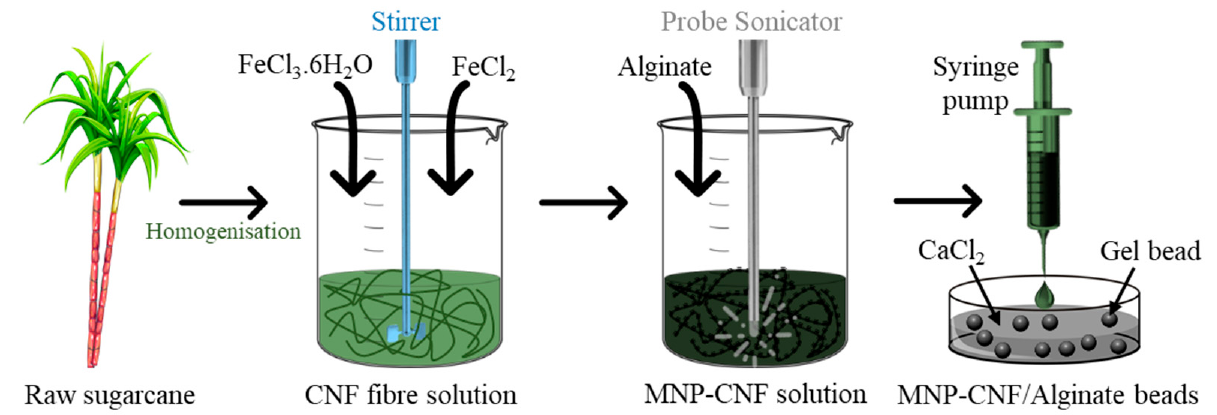
Figure 1. Schematic illustration of the fabrication method of magnetic nanocellulose incorporated alginate (MNP–CNF/alginate) beads.